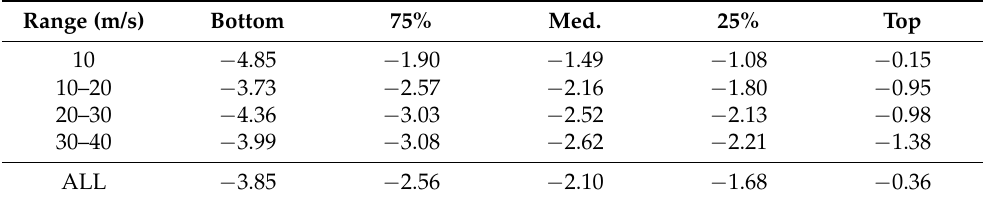
Table A2. Distribution of maximum deceleration (300 random vehicles, free deceleration).